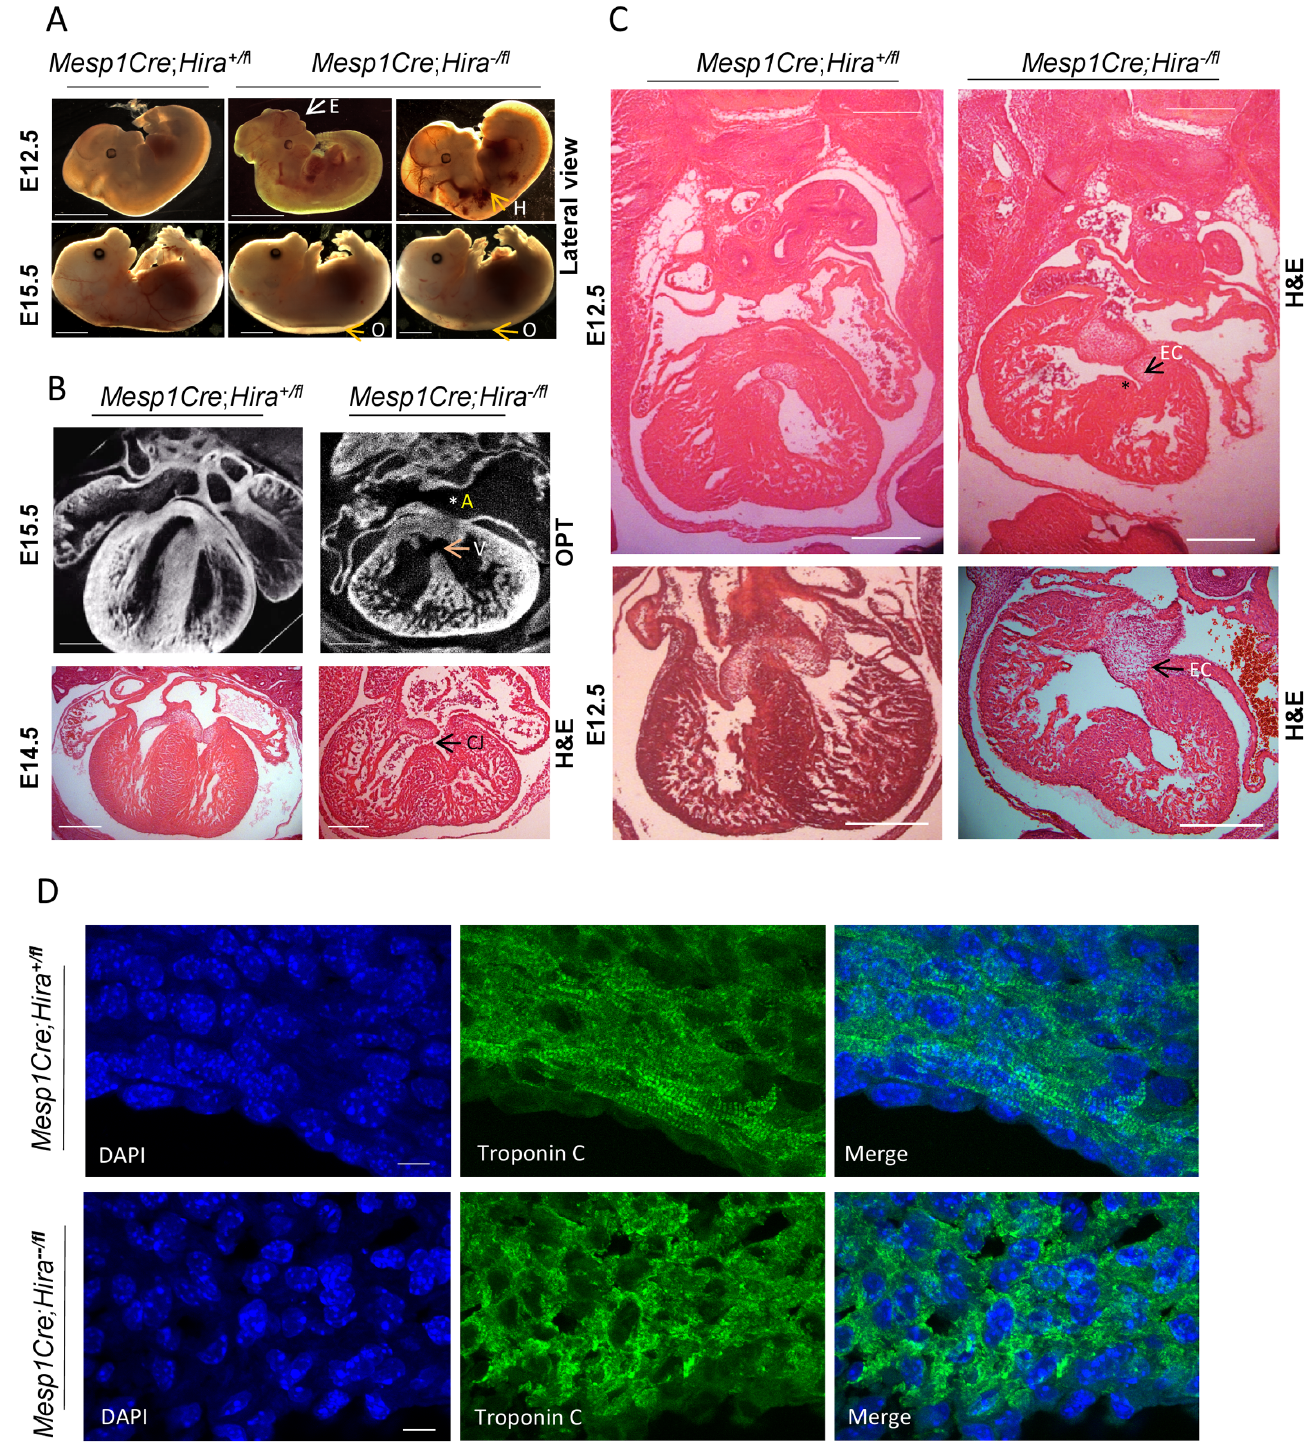
Fig 1. HIRA is required in the developing heart. A. Lateral view of littermate embryos with the indicated genotype. Mesp1Cre ; Hira -/fl embryos had a low penetrance external phenotype at E12.5: exencephaly (E) and light haemorrhage (H) are indicated in the mutants. At E15.5, all mutants showed severe oedema (O) as indicated. B. Transverse OPT reconstructions followed by virtual reslicing of E15.5 embryo trunks with the indicated genotype. VSD (V) and ASD (A) are indicated in the mutants. H&E of transverse sections of E14.5 embryos with the indicated genotype also showed a common atrioventricular junction (CJ) in the mutants as indicated. C . H&E staining of transverse sections from E12.5 embryos reveals a disruption of the